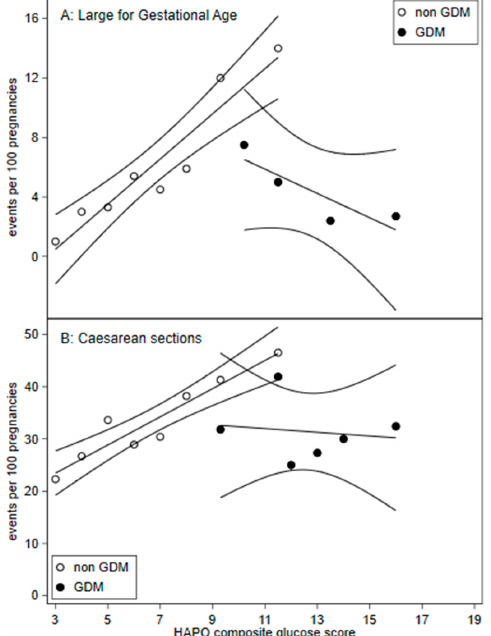
Figure 2. Frequency of ( A ) large for gestation age (birth weight > 90th percentile) and ( B ) caesarean sections across HAPO glucose composite scores with 95% confidence intervals. HAPO glucose composite scores were calculated by adding the HAPO glucose categories for fasting, 1 h, and 2 h plasma glucose. A. Large for gestational age: GDM HAPO glucose composite score were pooled for scores: 7 to 11, 13 to 14, and 15 to 19.